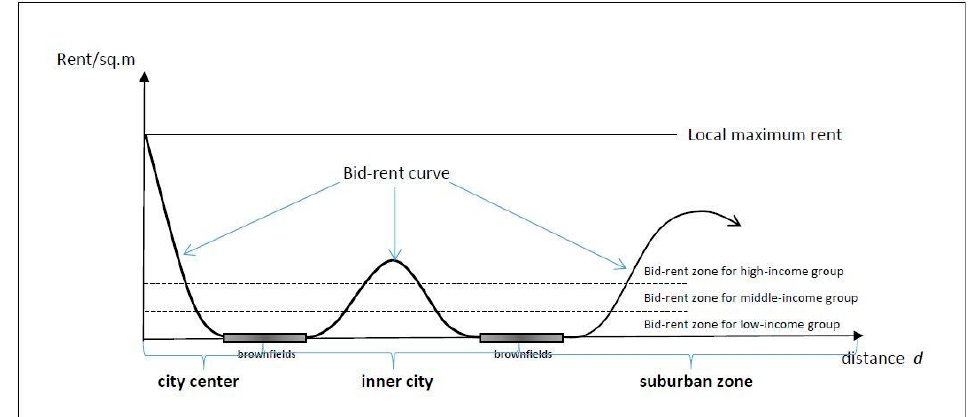
Figure 1. Hypothetical effects of brownfields on the bid–rent curve in urban space. Source: authors processing (inspired by McCan [46] p. 128).